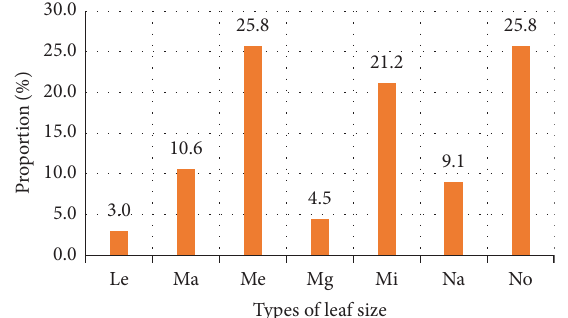
Figure 12: Proportion of the diferent types of leaf sizes: (Le) Leptophylls, (Ma) Macrophylls, (Me) Mesophylls, (Mg) Mega- phylls, (Mi) Microphylls, (Na) Nanophylls, and (No) Notophylls.